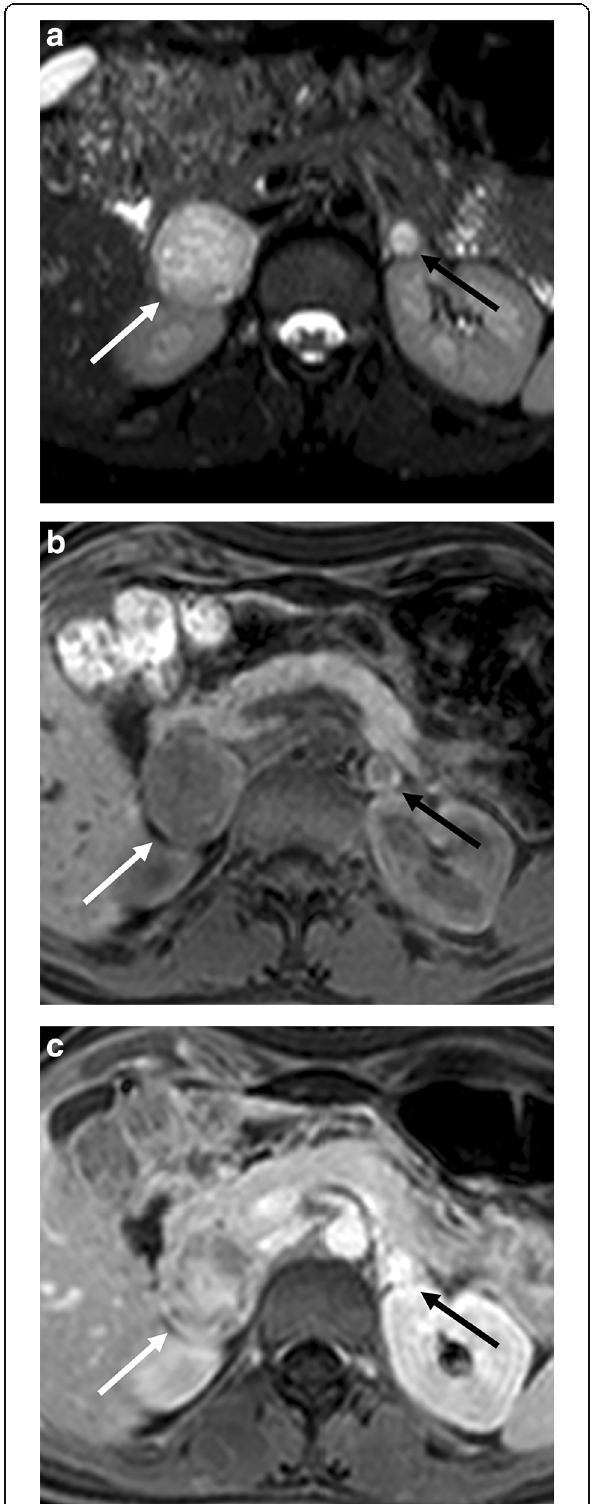
Fig. 6 Bilateral adrenal pheochromocytoma in a 27-year-old woman with multiple endocrine neoplasia type 2. Axial T2-weighted fat- saturated spin echo ( a ), three-dimensional fat-suppressed T1- weighted gradient recalled echo images before contrast injection ( b ), and in portal phase ( c ) images show a bilateral adrenal mass with high T2 signal intensity and strong and heterogenous contrast enhancement. The signal intensity is typically more inhomogenous in larger lesions (white arrow, right adrenal gland) than in smaller ones (black arrow, left adrenal